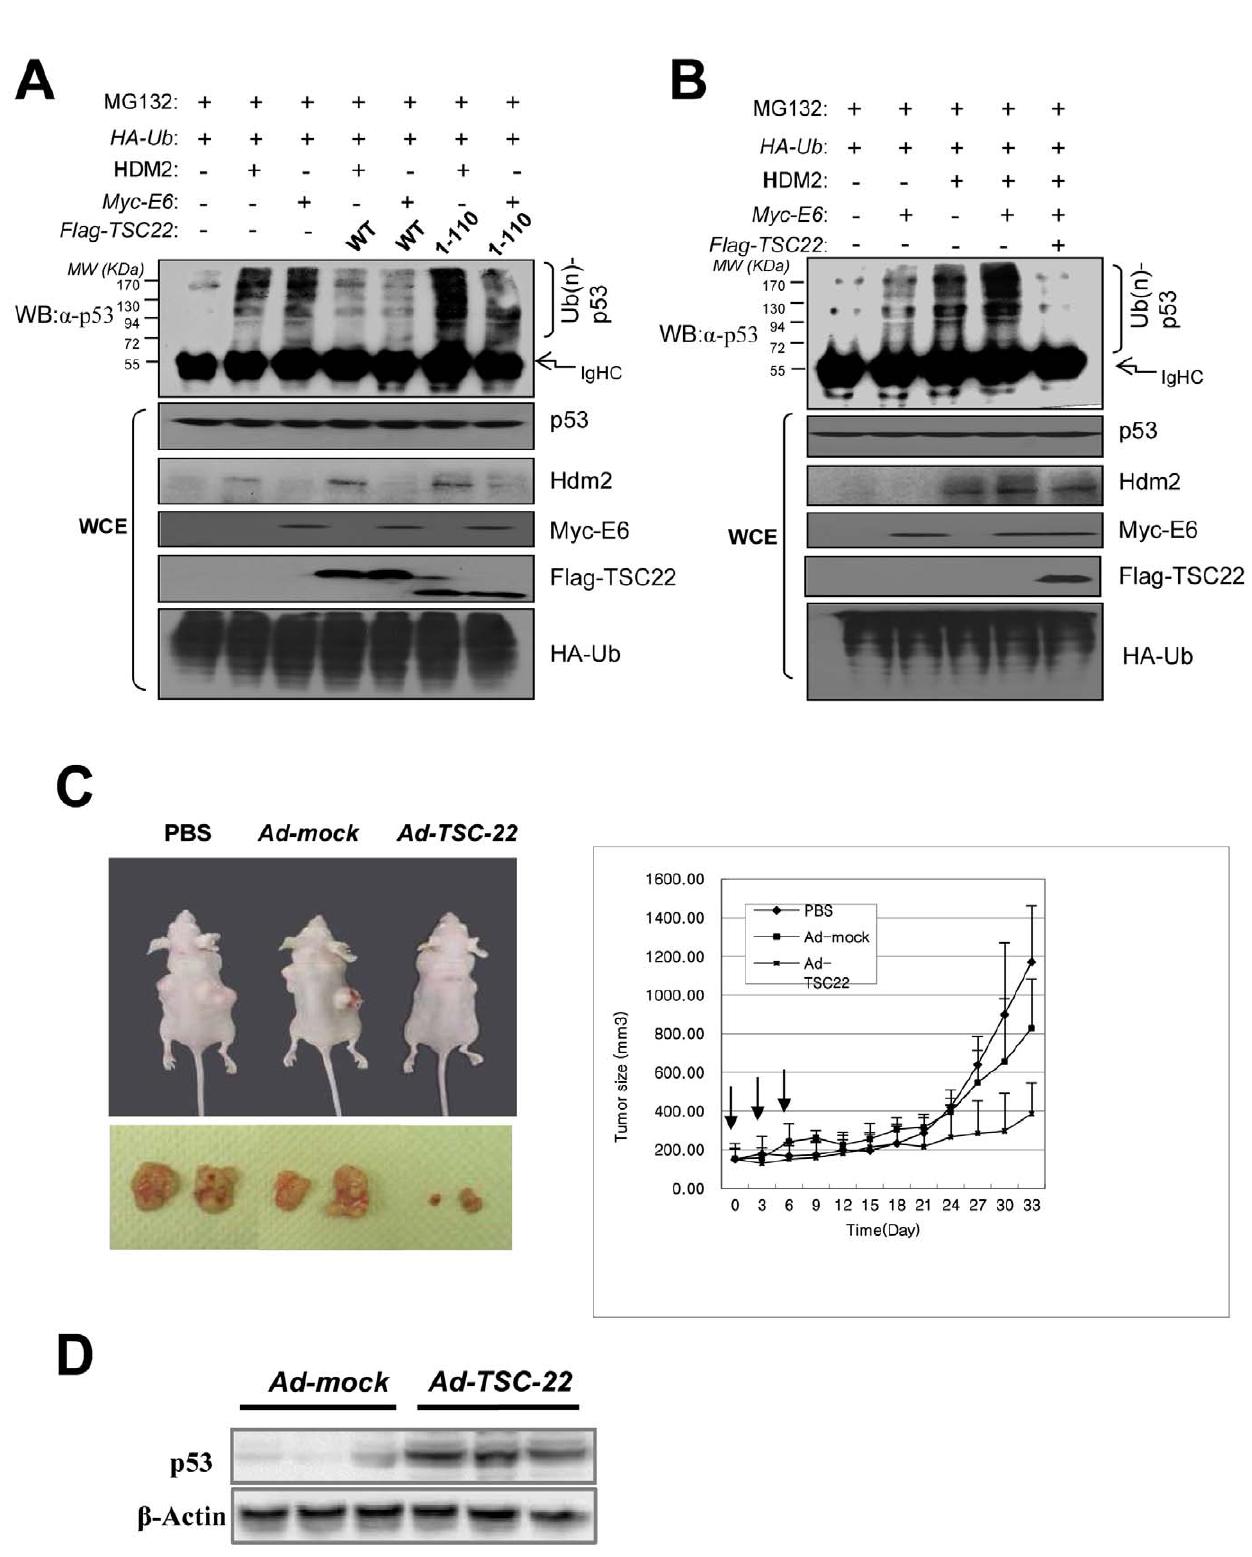
Figure 6. TSC-22 inhibits tumor growth in nude mice. (A) HDM2 and Myc-E6 were transfected with indicated plasmids into H1299 cells. The transfected cells were treated with MG132 (20 m M) for 5 h before harvest. Cell lysates were immunoprecipitated with an anti-HA antibody. Ubiquitinated p53 was detected by Western blotting with an anti-p53 antibody (DO-1). Ubiquitinated p53 is indicated as Ub(n)-p53 (upper panel). The expression of total p53, HDM2, Flag-TSC-22 and HA-Ub proteins are shown in the lower panels. (B) Flag-tagged wild type (WT) or mutant TSC22 1– 110 was co-transfected with the indicated plasmids into H1299 cells. The transfected cells were treated with MG132 (20 m M) for 5 h before harvest. Cell lysates were immunoprecipitated with an anti-HA antibody. Ubiquitinated p53 was detected by Western blotting with an anti-p53 antibody (DO-1). Ubiquitinated p53 is indicated as Ub(n)-p53 (upper panel). The expression of total p53, HDM2, Flag-TSC-22 and HA-Ub proteins are shown in the